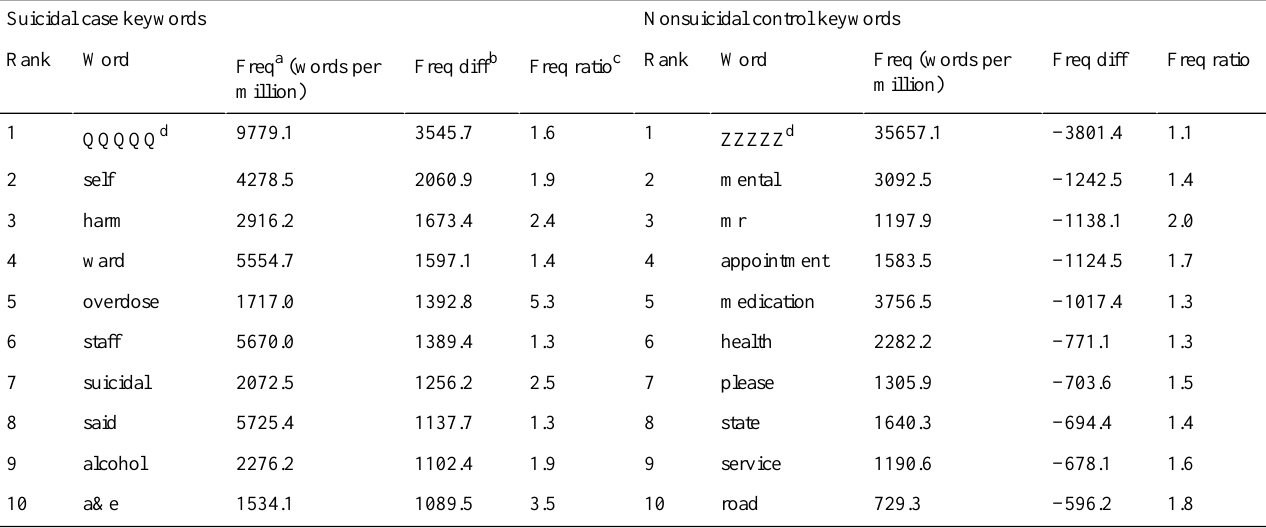
Table 4. Ranked keyword list for suicidal case and nonsuicidal control subcorpora.